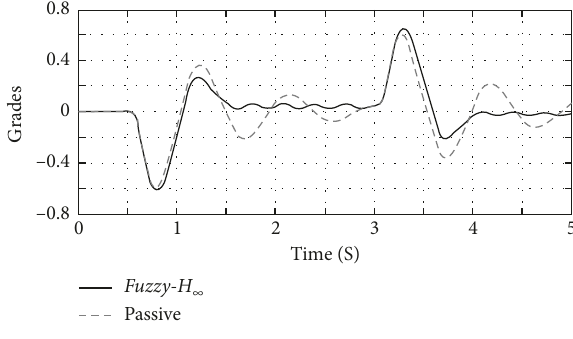
Figure 14: Pitch angle displacement ( θ ).